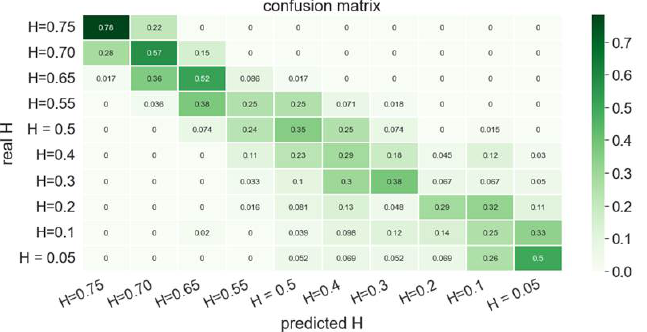
Figure 16. Confusion matrix related to the trained classifier applied to ten fractional Brownian